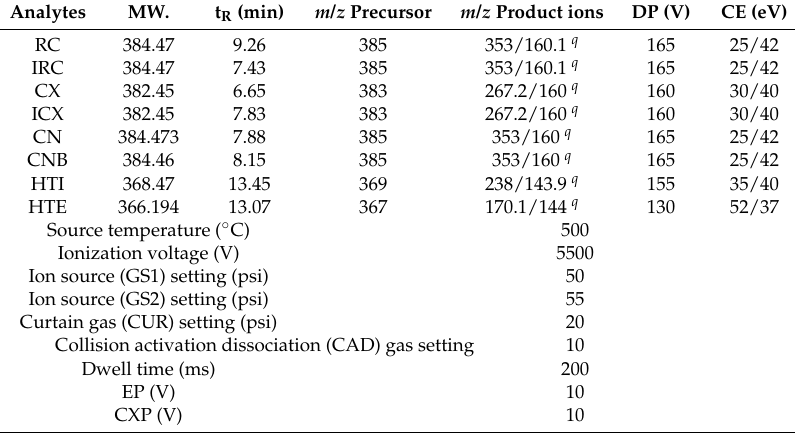
Table 3. MS parameters of the eight targeted